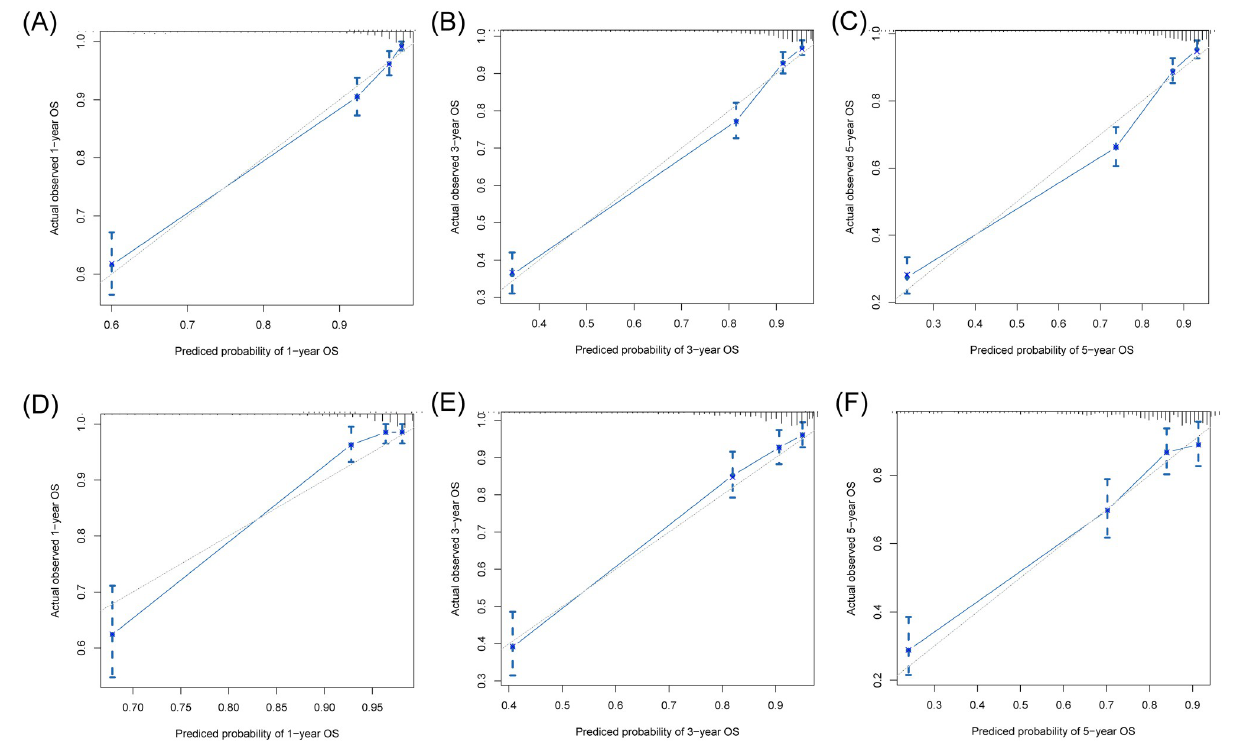
Fig 2. Calibration curves of the NomogramA using the training cohort for predicting the 1- (A), 3- (B), and 5- (C) year OS rates of patients with NF- pNET. Calibration curves of the NomogramA using the validation cohort for predicting the 1- (D), 3- (E), and 5- (F) year OS rates of patients with NF-